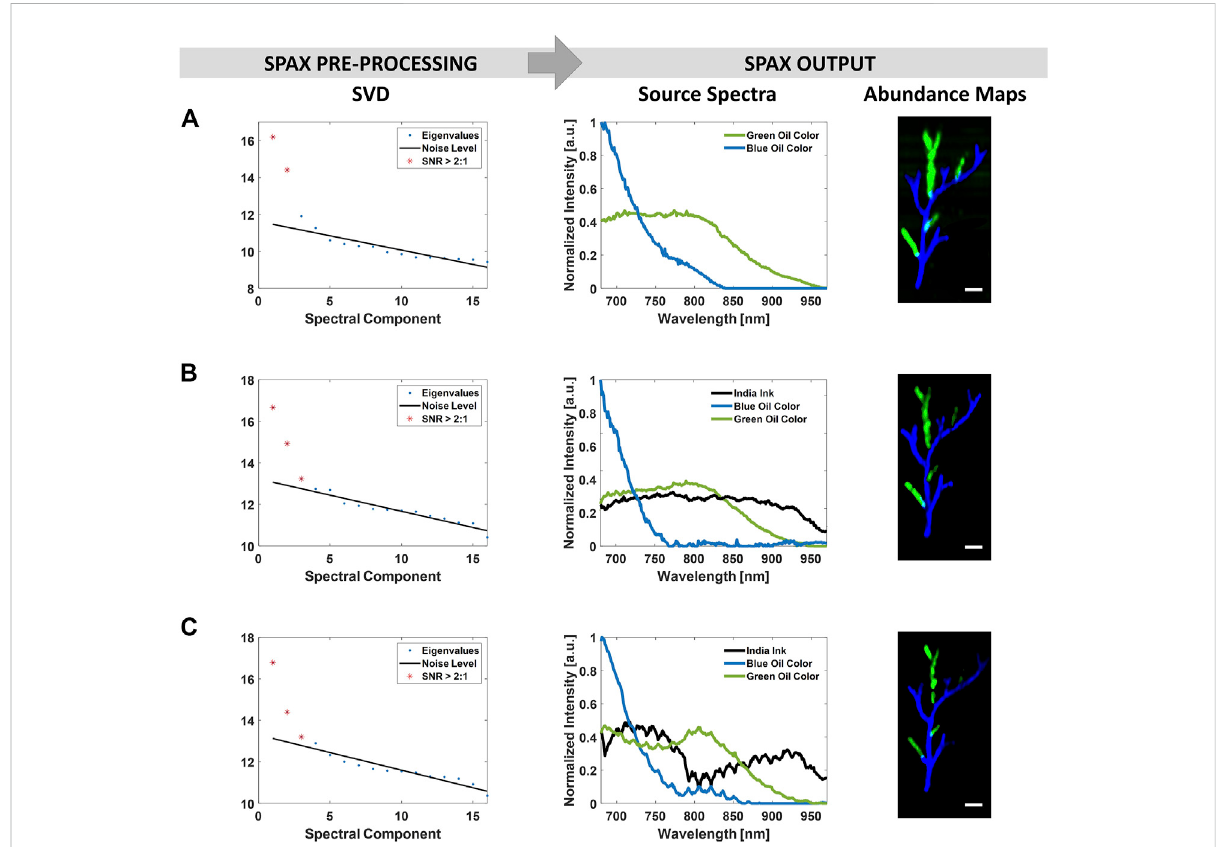
FIGURE 6 SPAX framework applied on the vessel-mimicking phantoms without background absorption (row (A) ), with 0.05% v/v India Ink (row (B) ), and 0.1%v/vIndiaInk(row (C) )asbackgroundabsorption.TheSVDanalysis,implementedwithintheSPAX,automaticallydeterminestheoptimalnumber ofsourcecomponentsthatissigni fi cantlyabovethenoise fl oor.Thishasresultedas2in (A) and3in (B – C) whereinadditiontoblue/greenoilcolors, theIndia ink ispresentas abackgroundabsorber. The unmixed spectra and abundance mapsobtained as the SPAX outputsshow theextracted dyes from the vessel-mimicking phantoms. The scale bar size is 2